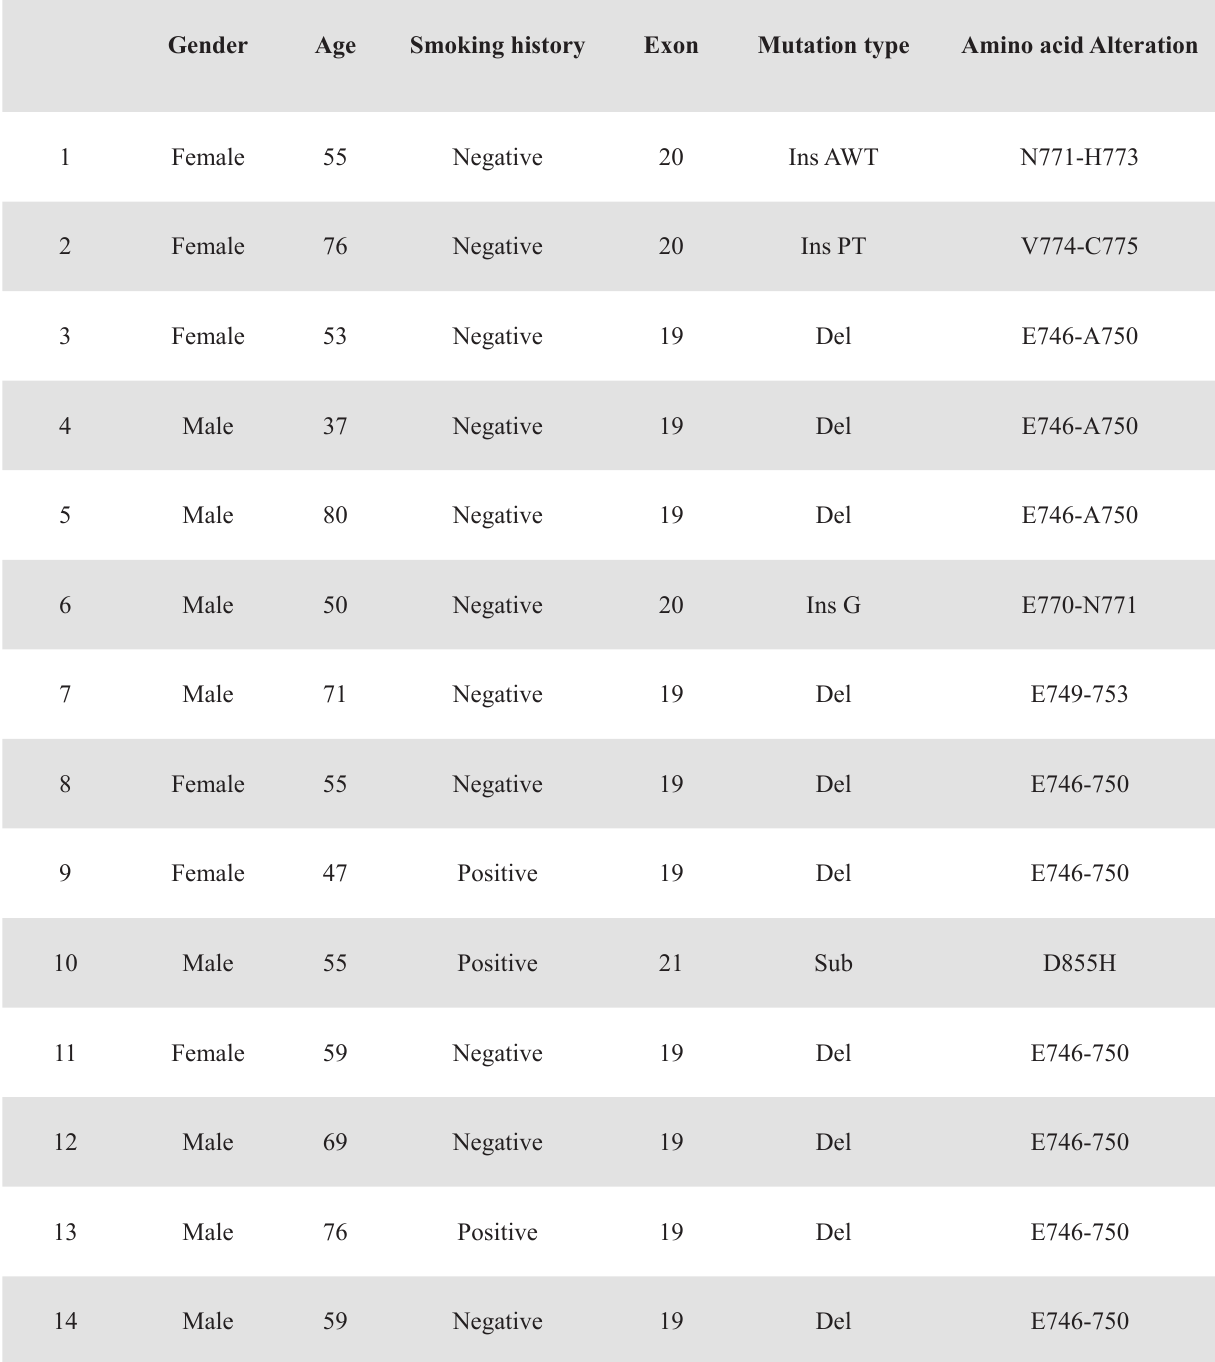
Table 1 . Characteristics of 14 cases of lung cancer with EGFR